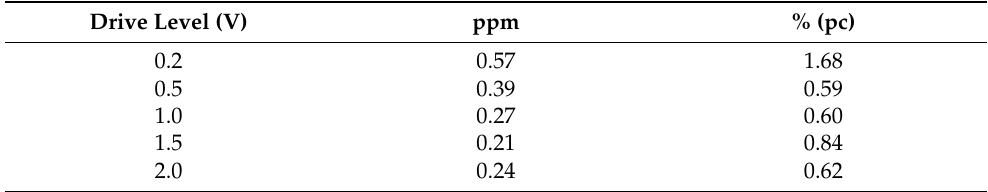
Table 2. Accuracy of measurement of frequency (ppm) and motional resistance (%) according to the drive level of the QCM sensor in the air.